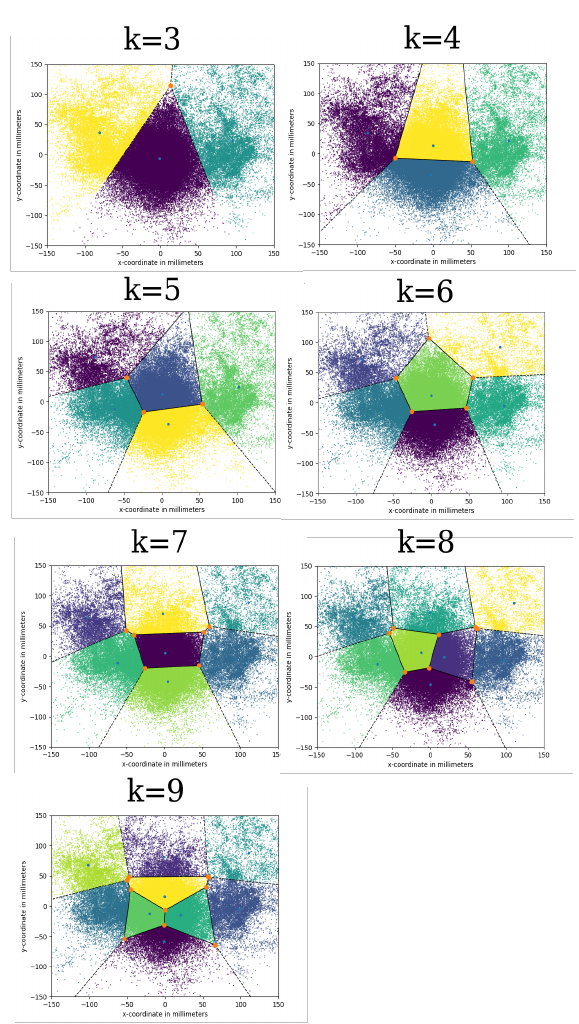
Figure 7: Graphical output of the k -means clustering algorithm with 3 to 9